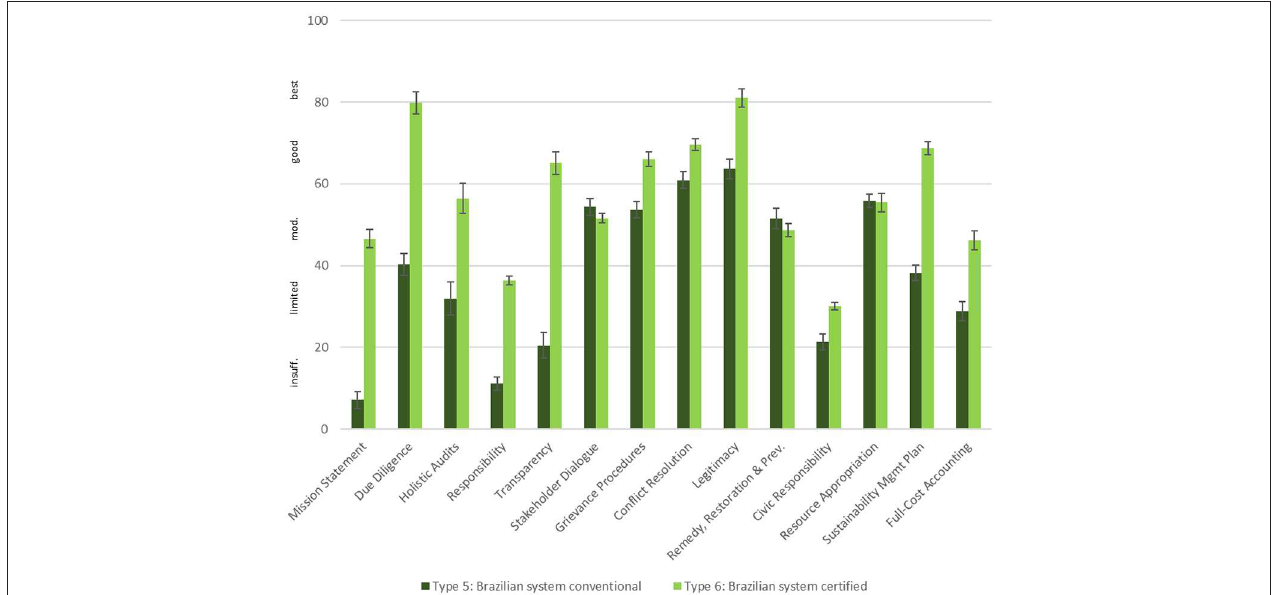
FIGURE 9 | Sustainability performance of typical Brazilian coffee production systems in “Good